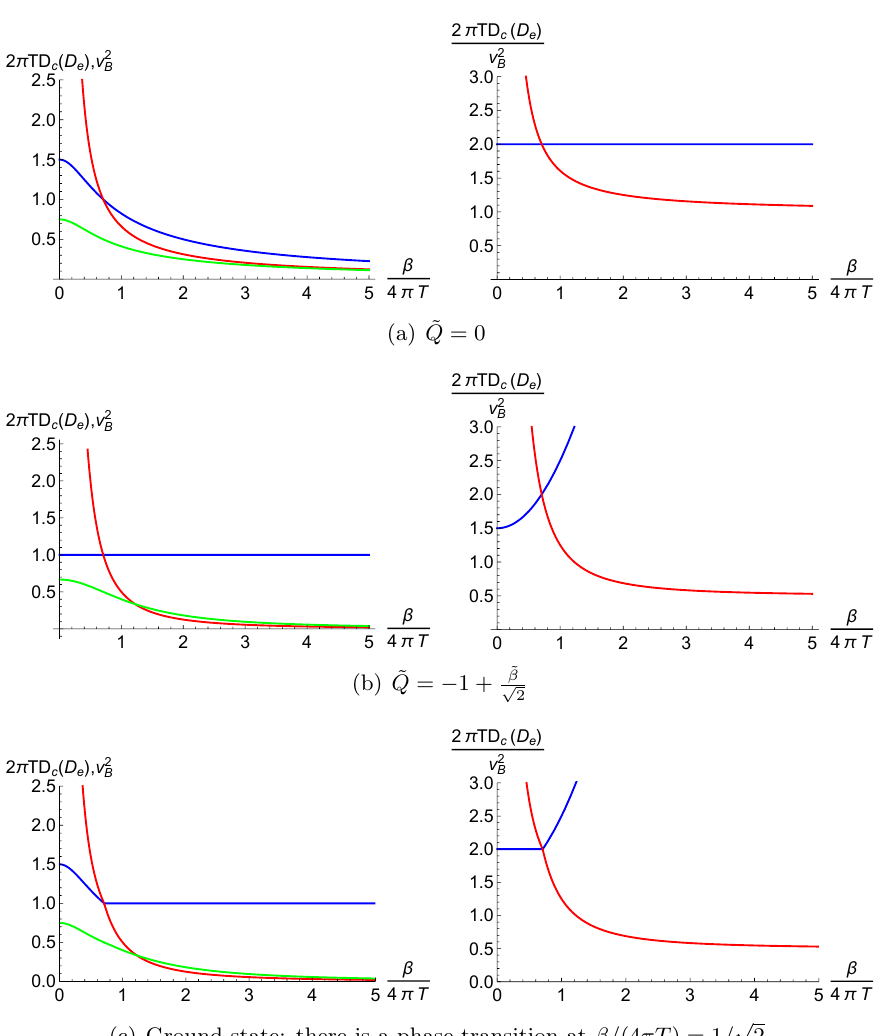
Figure 4 . Di(cid:11)usion constants of the axion-dilaton model at zero density for ~ Q = 0 (a), for ~ Q = (cid:0) 1 + ~ (cid:12) p (b), and for the ground state (c). The blue curve is for D c and the red curve is for 2 D e . The green curve displays v 2 B